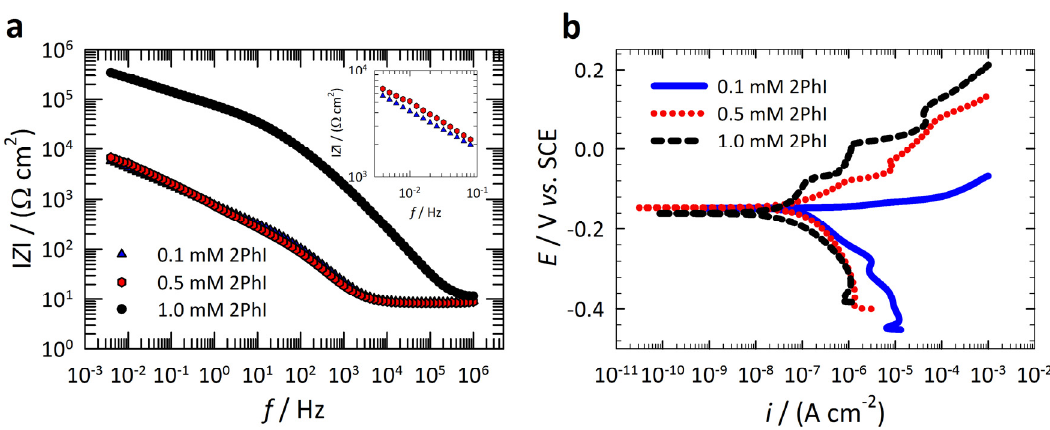
Figure 2. ( a ) Bode plots and ( b ) PD curve measurements for Cu samples after 100 h immersion in 3 wt.% NaCl solution containing 0.1, 0.5 and 1.0 mM